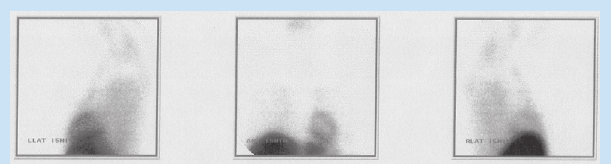
Table I. Clinical indications for